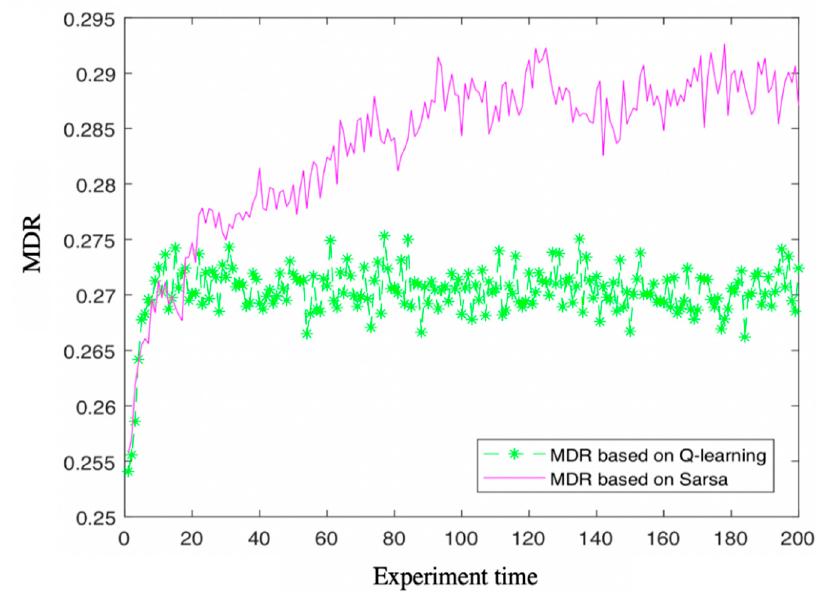
Figure 8. The comparison of MDR based on SARSA and Q-learning.